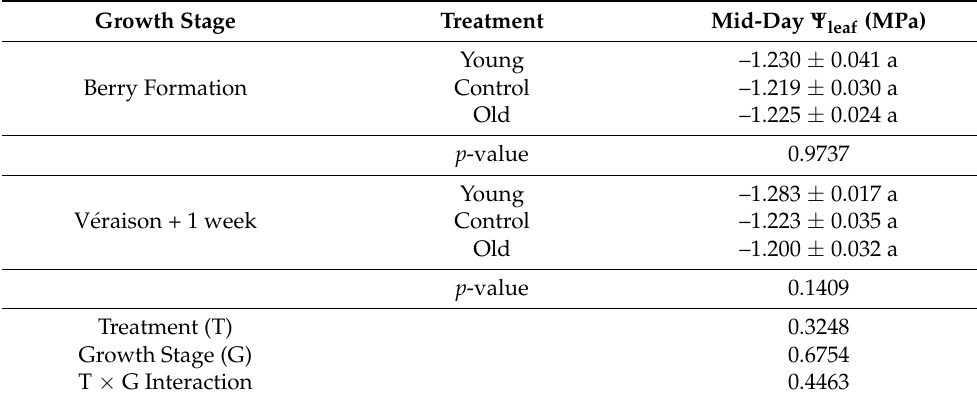
Table 4. Two-way analysis of variance (ANOVA) with interaction showing mid-day leaf water potential ( Ψ leaf ) measurements by treatment and growth stage during the 2019 growing season ( n = 6). Treatment means followed by standard error of the mean. Different letters within a column indicate significant differences between treatment groups based on Tukey